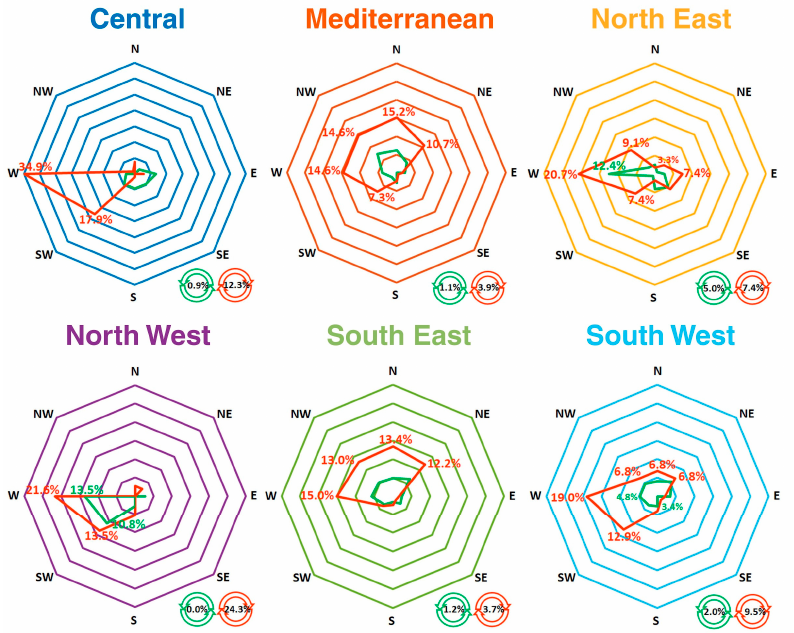
Figure 5. Circulation types based on the GWT18 circulation type catalogue corresponding to the clusters described in Figure 1 (color-coded accordingly with the colors for each cluster). Only data corresponding with the time of EARLINET lidar measurements were used. For each cluster, the wind direction is shown for cyclonic (red line) and anticyclonic (green line) circulations. The percentage shown for each cluster represents the total number of observations of the dominant wind direction. For each cluster, the percentage of undefined cyclonic (green circle) and anticyclonic (red circle) circulation is shown.